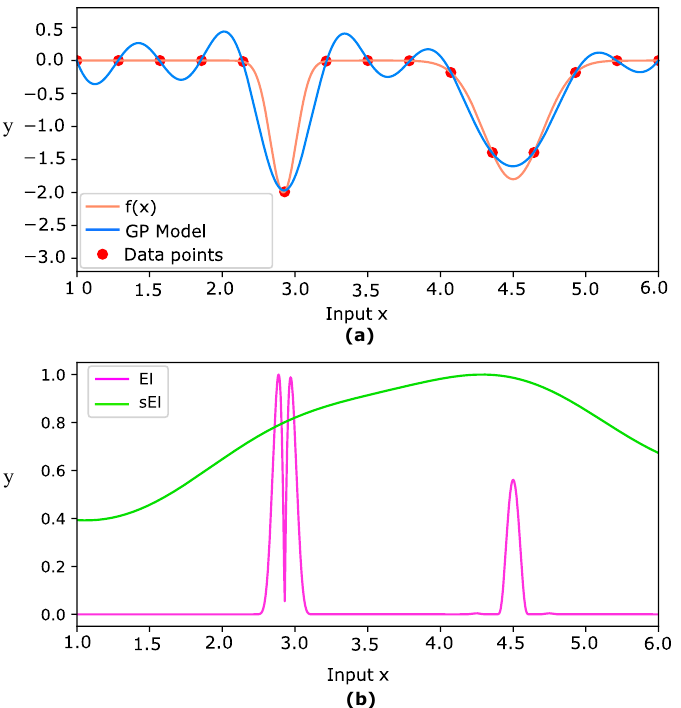
Figure 4. ( a ) The GP model and ( b ) comparison of acquisition functions EI and sEI for an objective function f ( x ) .